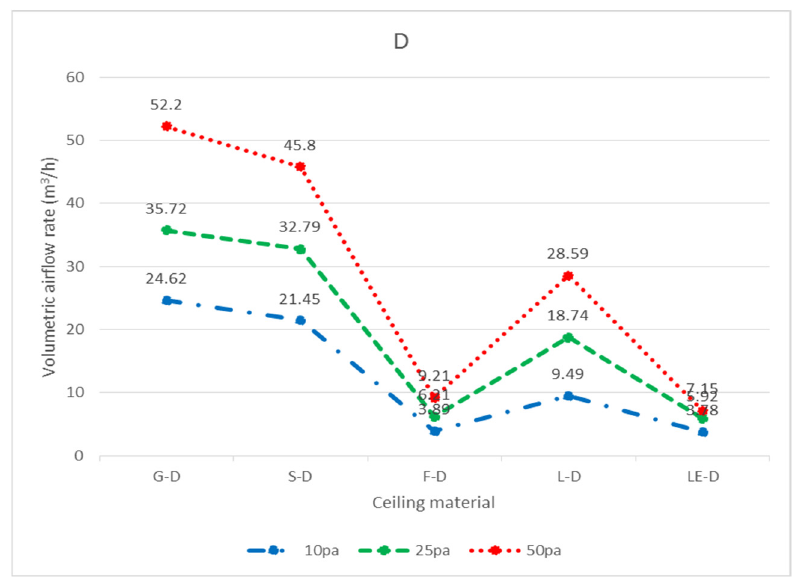
Figure 16. The unit leakage volume (m 3 /(h.m.)) of each specimen under each pressure difference with airflow from bottom to top (U).